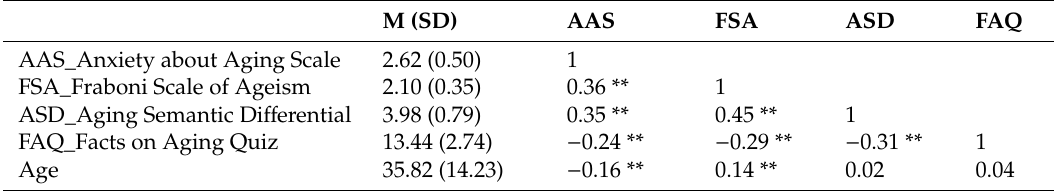
Table 1. Correlations between the variables included in the study (** p <